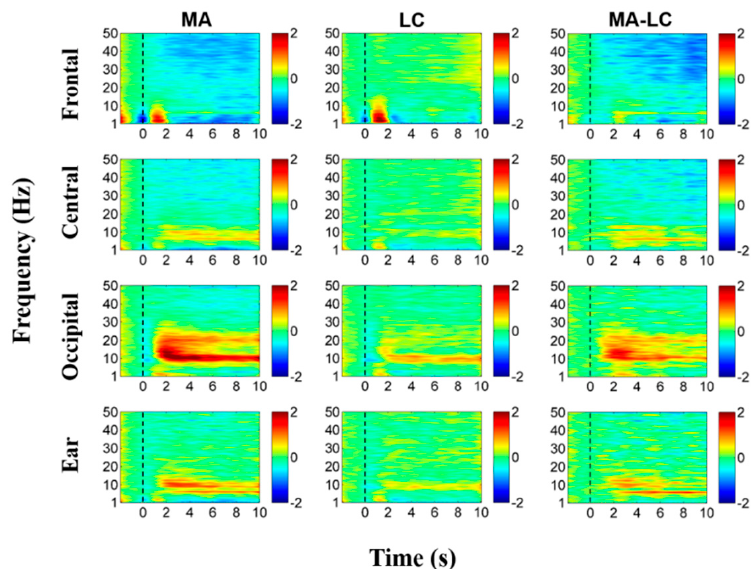
Figure 6. Grand average ERD/ERS maps of each ROI during MA and LC, and their differences (MA-LC). The ERD/ERS maps of ear area (denoted by ‘Ear’) are obtained by averaging the six electrodes attached behind both ears (three electrode for each side). The x- and y-axis of each map indicate the task time from − 2–10 s based on task onset (t = 0 s), and the frequency band ranging from 1 to 50 Hz, respectively. ERD and ERS are presented in blue and red, respectively.